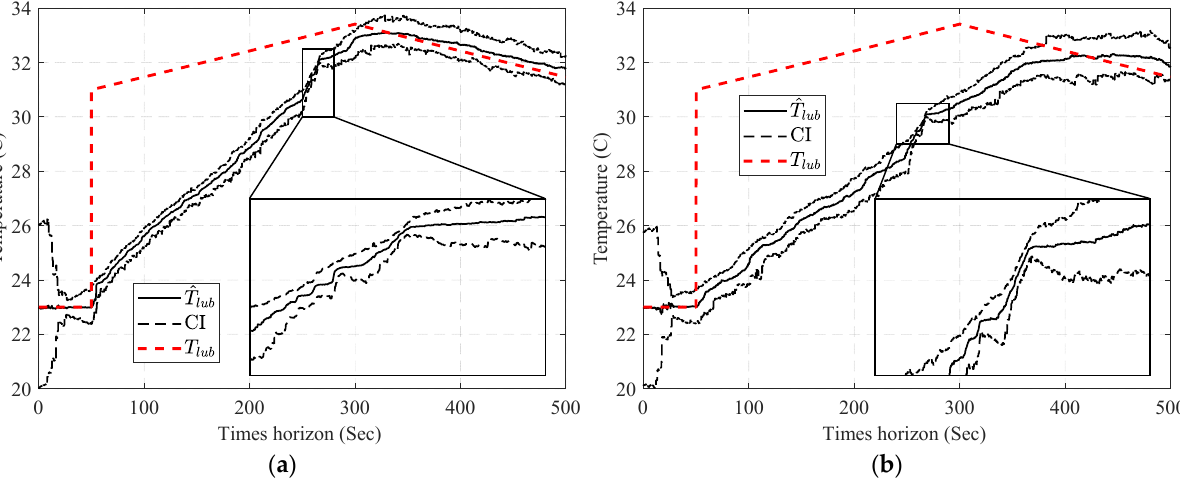
Figure 9. Result of the estimated T lub , using PF: ( a ) low noise scenario and ( b ) high noise scenario. To overcome this issue, an adaptation of resampling (explained in Section 3.1.1) is used in this study. Figure 10 shows the performance of the combination of PF and the adapted resampling step in the estimation of T lub